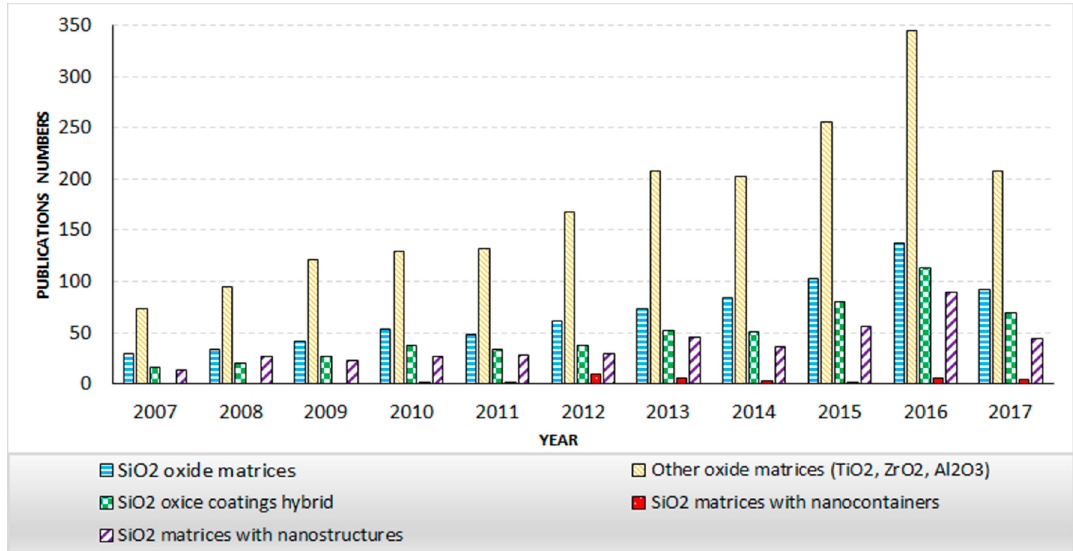
Figure 1. Historical publication data concerning sol-gel matrices for alloys substrates.